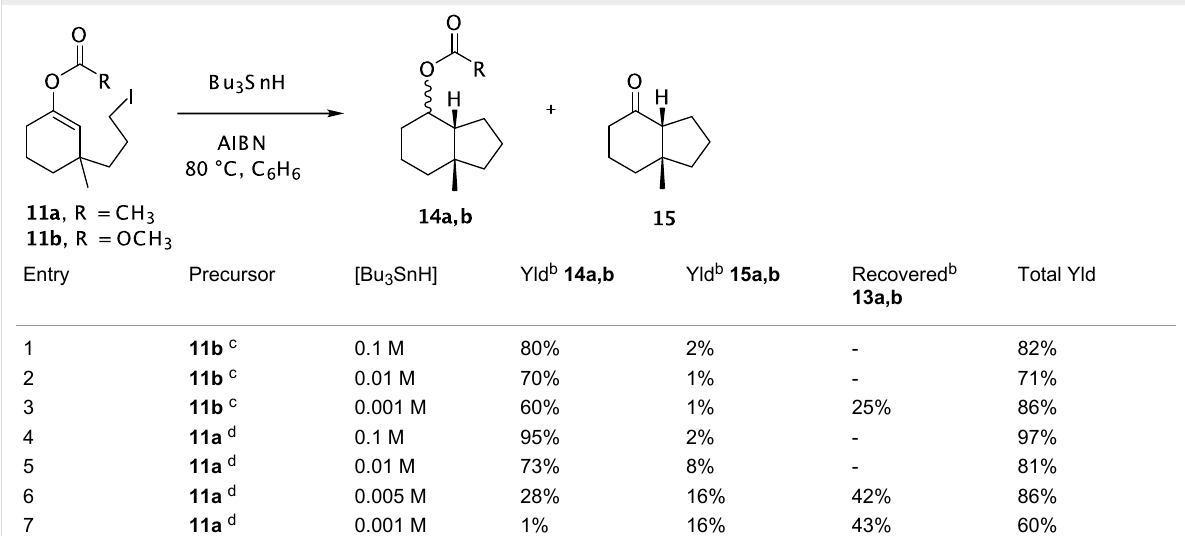
Table 1: Product Ratios in Bu 3 SnH Mediated Cyclizations of 11a,b a